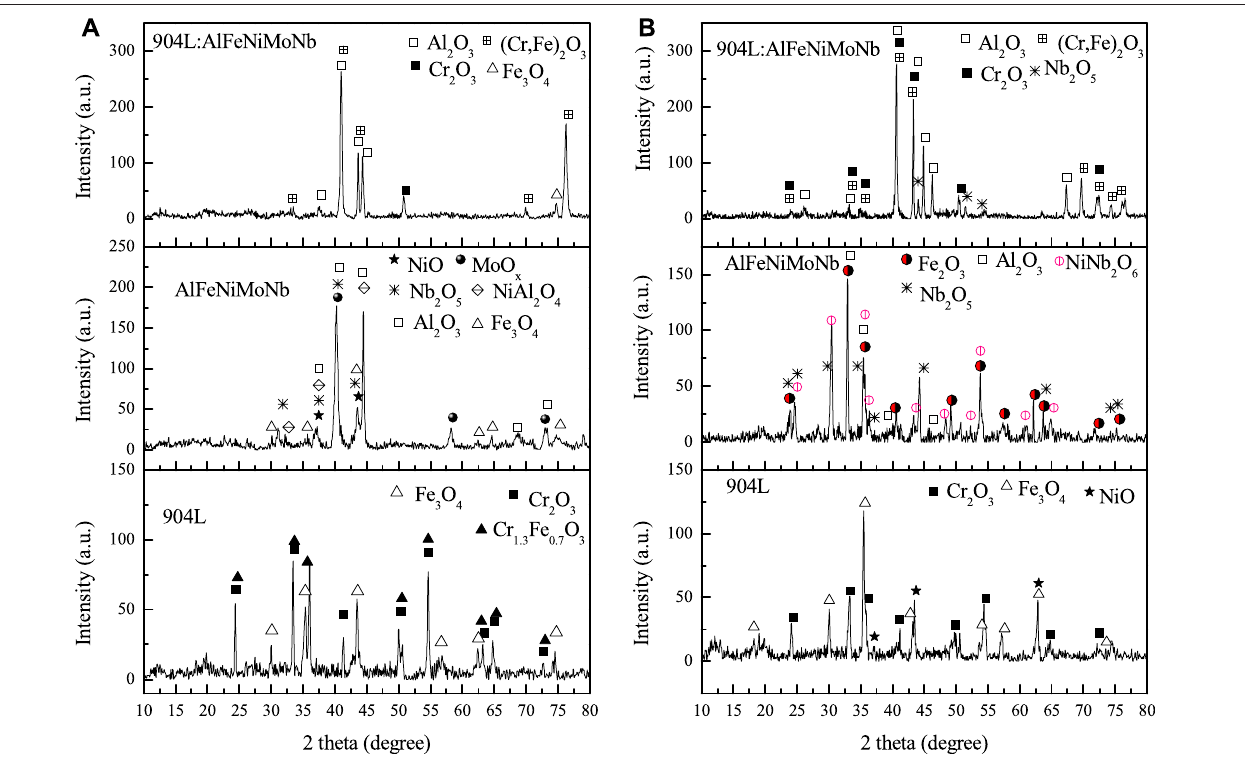
FIGURE 9 | X-ray diffraction patterns of the corroded surfaces of alloys after high temperature chloride corrosion at 700 ° C and 800 ° C for 55 h under N 2 – 2.6 vol.% CO 2 – 1.3 vol.% O 2 -2,700 vppm HCl gaseous environment [ (A) for 700 ° C; (B) for 800 °